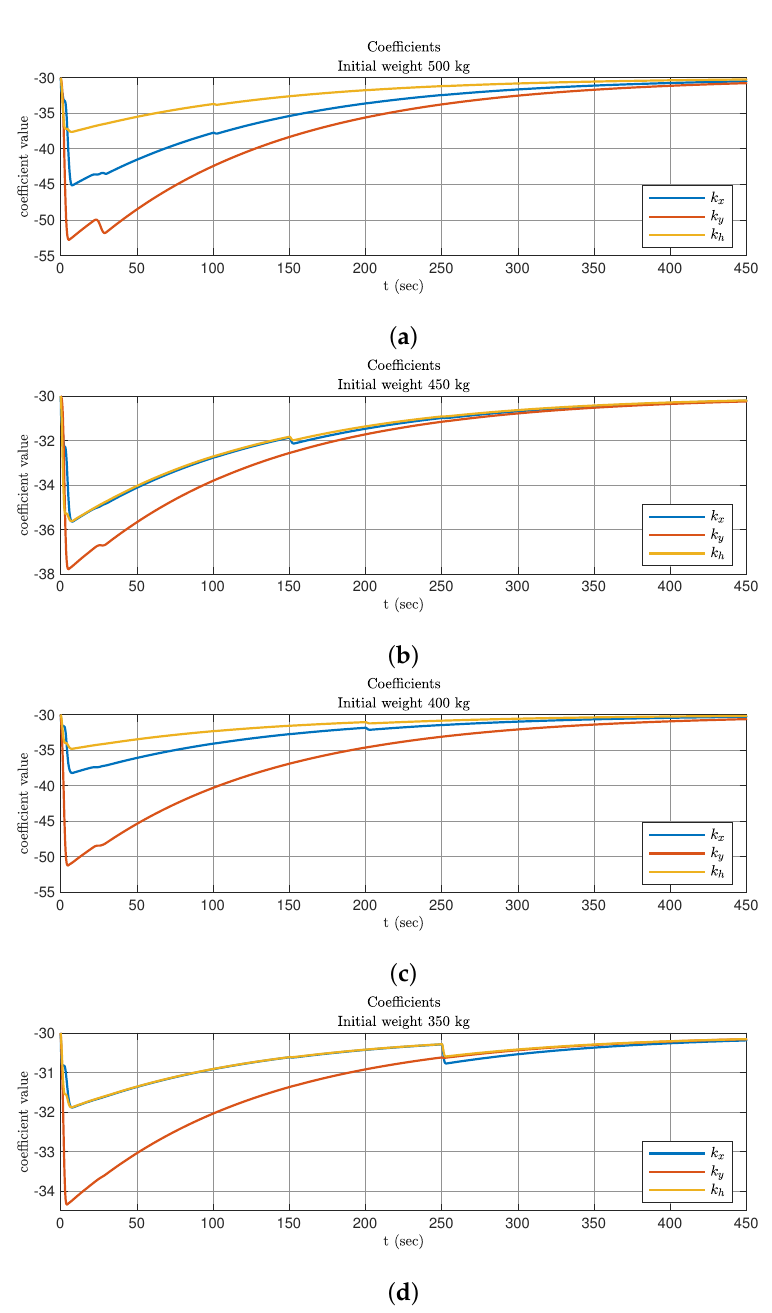
Figure 8. Coefficients of regulators when controlling a group of UAVs of variable mass with initial mass values of 500 kg ( a ), 450 kg ( b ), 400 kg ( c ), and 350 kg ( d